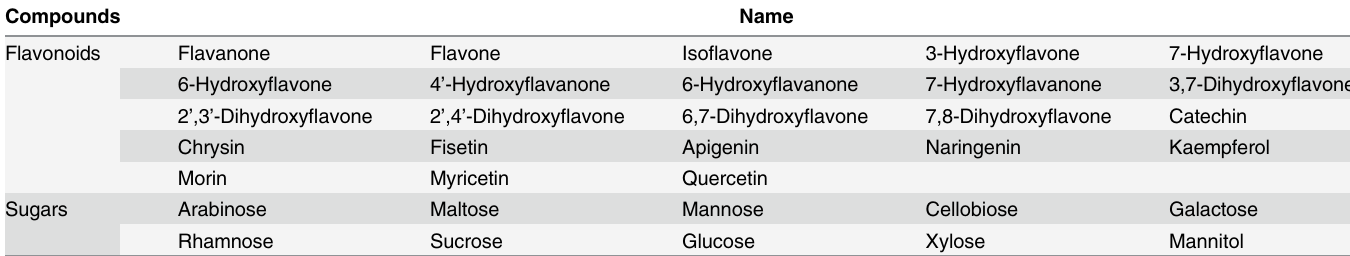
Table 1. List of flavonoids and sugars tested for their ability to support growth and/or induce the biphenyl catabolic pathway of strain U23A.